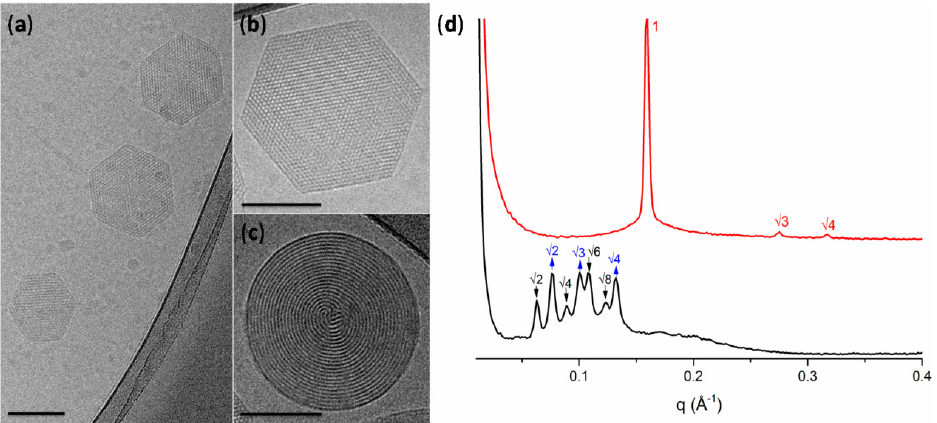
Figure 3. ( a – c ) Cryo-TEM images of hexosomes (all scale bars represent 100 nm); ( d ) SAXS profiles of the lipid-based liquid crystals without (black) and with undecylenic acid (red). Black, down arrows show the reflections of the Im3m cubic phase; blue, up arrows show the reflections of the Pn3m cubic phase. The reflections are annotated above the Bragg peaks. Adapted by Mioni´c Ebersold et al. [51].